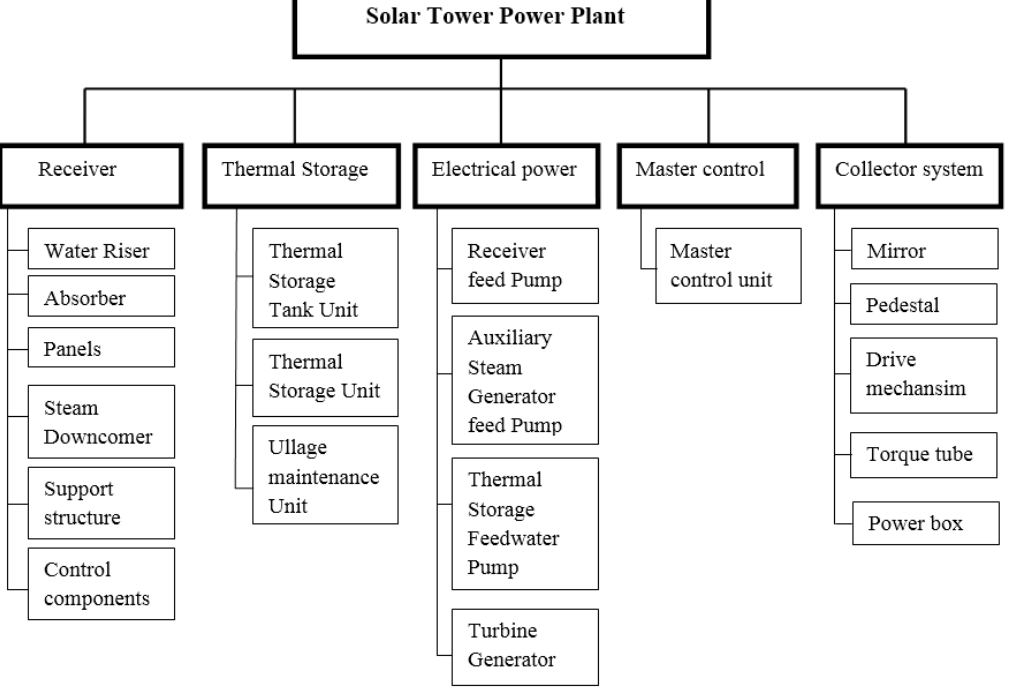
Figure 2. STPP components. Figure 2. STPP 3.1. Failure Mode Effects and Criticality Analysis (FMECA)